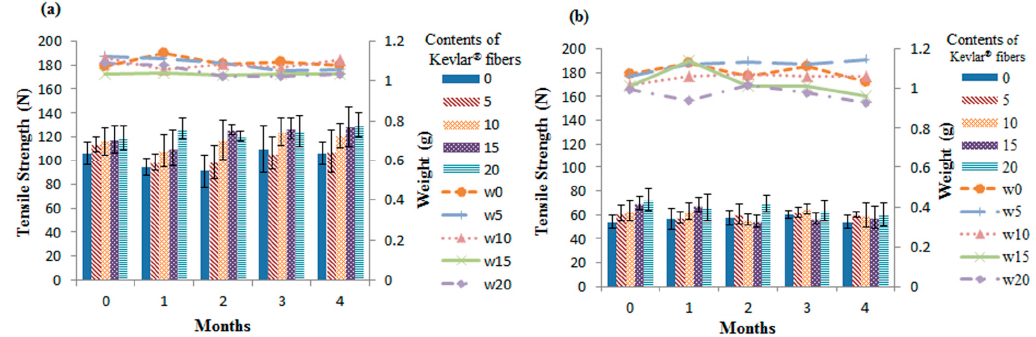
Figure 1. Tensile strength and weight along the ( a ) cross machine direction (CD) and ( b ) machine direction (MD) of recycled Kevlar ® /PET/LPET nonwoven geotextiles that are immersed in H 2 O at 23 °C for 4 months.